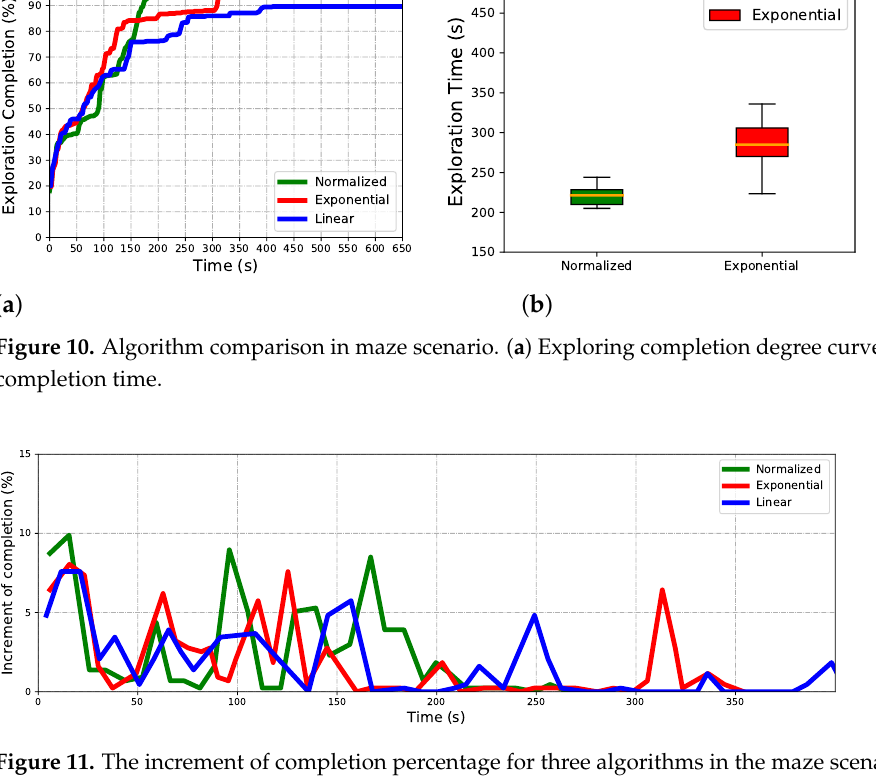
Figure 11. The increment of completion percentage for three algorithms in the maze